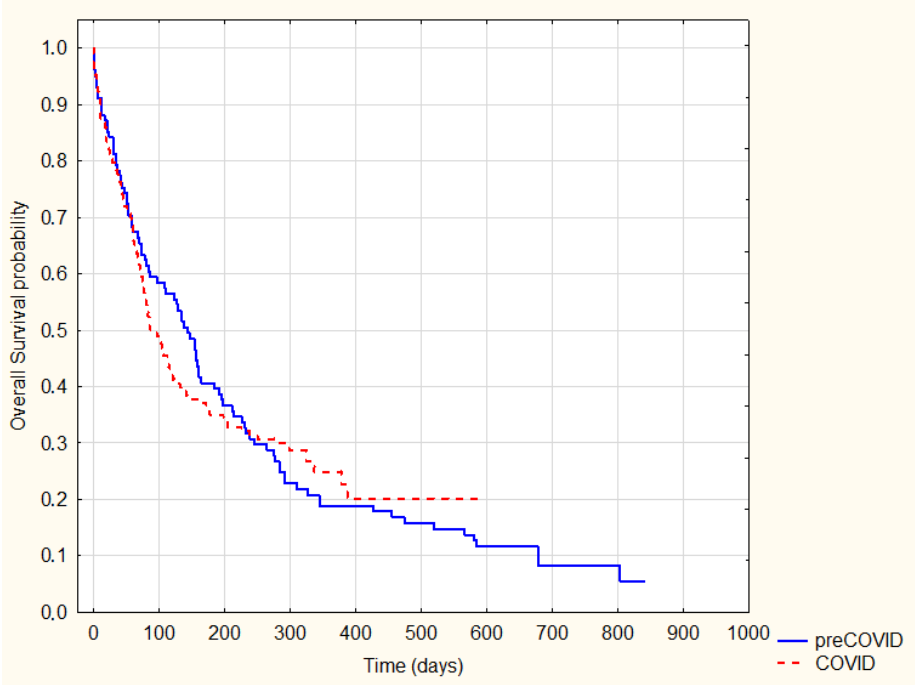
Figure 2. Kaplan–Meier Survival Analysis—radical vs. non-radical treatment, log-rank p = 0.0001.